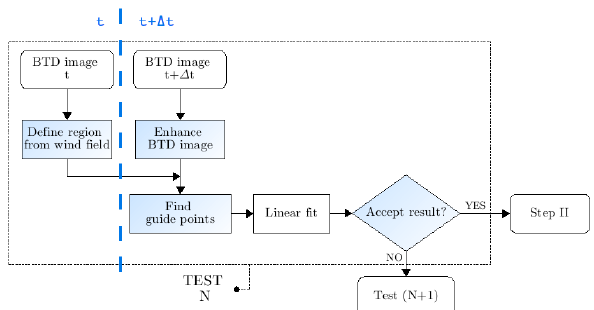
Fig. 4. Schematic representation of a test in Step I. Inputs: Contrail Fig. 04. Schematic representation of a test in Step I. Inputs: Contrail position in the BTD image at t and BTD image at t + 1t . Each position in the BTD image at t and BTD image at t + ∆ t . Each shaded box has diferent internal thresholds/definitions in each test. shaded box has diferent internal thresholds/definitions in each test. The output (input for Step II) is the position of the line at t + 1t . The output (input for Step II) is the position of the line at t + ∆ t .